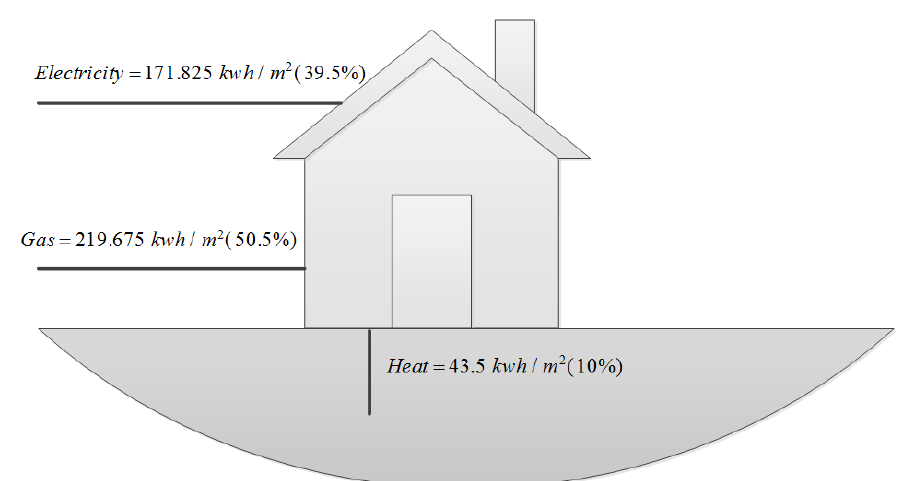
Figure 3 . The role of the heat pump.